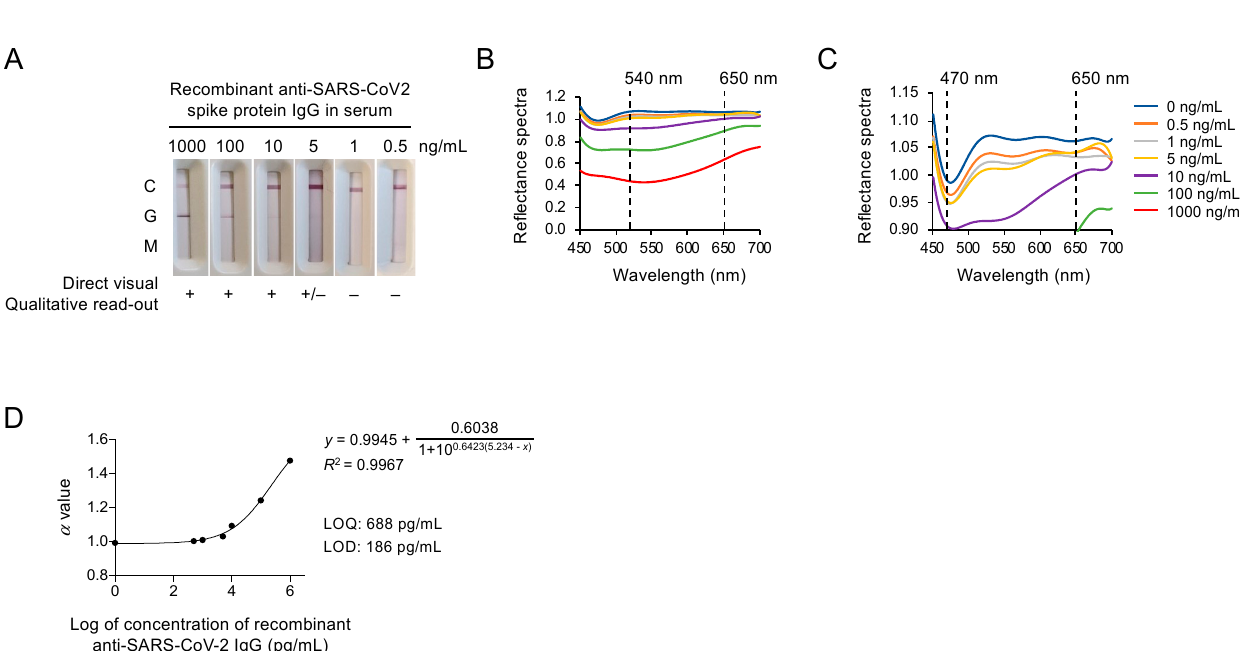
Figure 1. The spectrum analyzer provided an excellent detection limit. ( A ) The coronavirus disease 2019 (COVID-19) IgM/IgG test strips loaded with predetermined amounts of spiked IgG. ( B ) The reflectance spectra of the predetermined amounts of spiked IgG in a standard scale. ( C ) The reflectance spectra of the predetermined amounts of spiked IgG in an amplified scale. ( D ) Four-parameter logistic (4-PL) curve fit for the α value of the anti-SARS-CoV-2 IgG at the concentrations of 0.5, 1, 5, 10, 100, and 1000 ng/mL. The error bar that indicates the standard deviation was included but was too small to be visible.